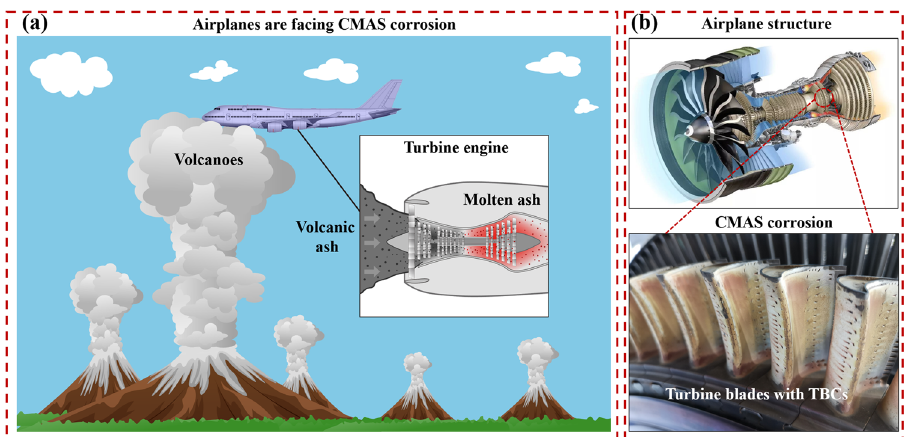
Fig. 1 TBCs in aircraft engines threatened with CMAS corrosion. a Volcanic ash in the air from a volcanic eruption. b Typical TBCs spallation of moving vanes under CMAS corrosion